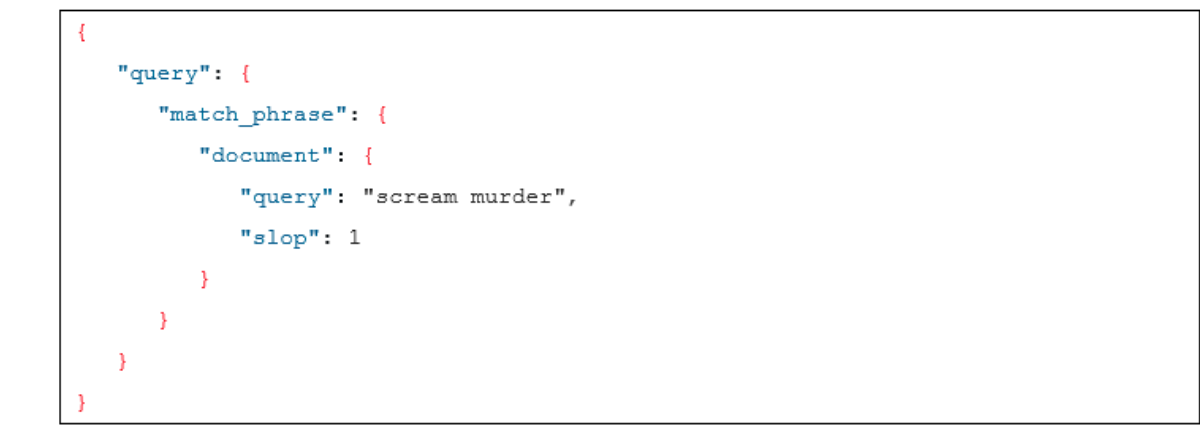
Figure 4. An example of a proximity query.